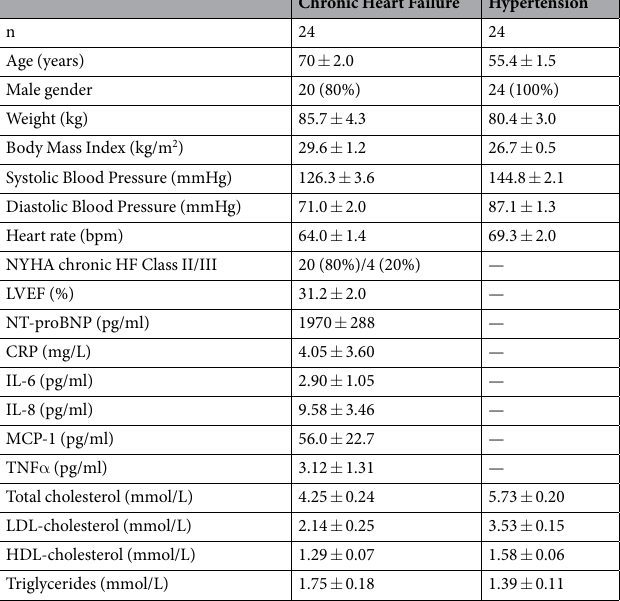
Table 2. Patient